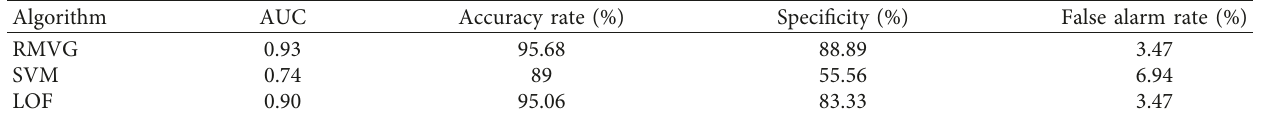
Table 7: Performance comparison of three machine learning algorithms.